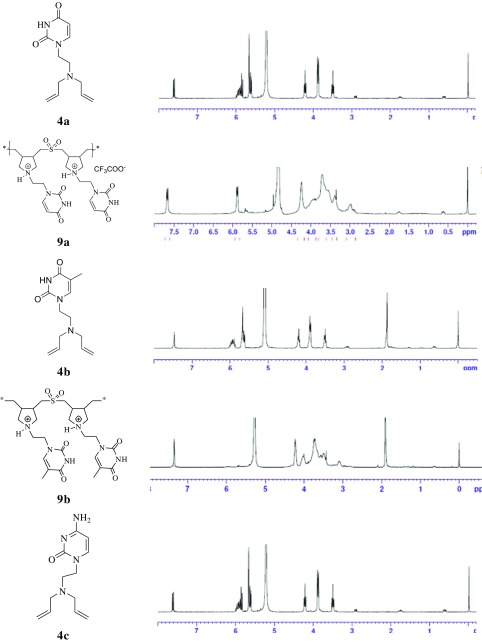

1H NMR spectra of monomers 4a–c and pyrimidine-SO2-copolymers 9a–c.